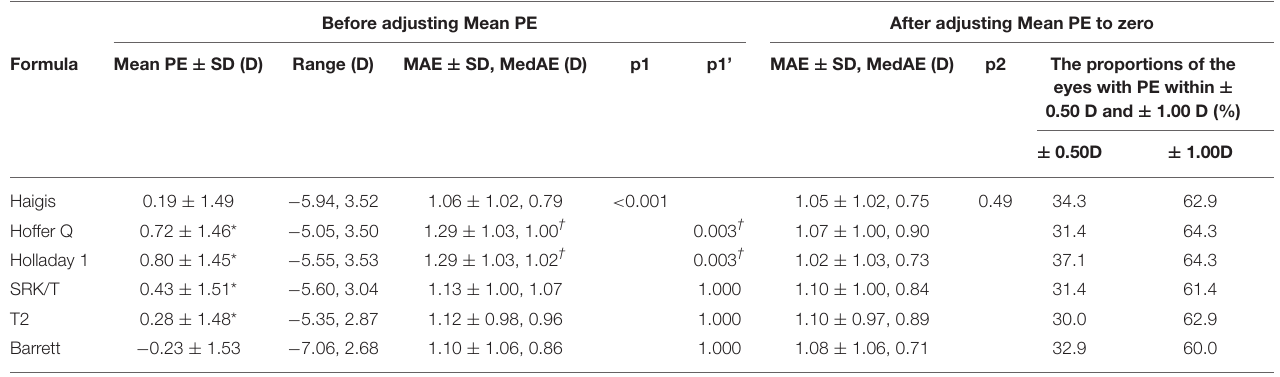
TABLE 3 | Postoperative refractive results of all